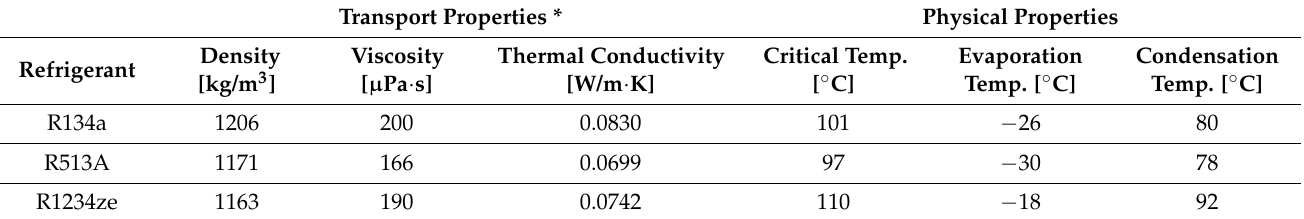
Table 8. Transport and physical properties for R134a and its substituents.